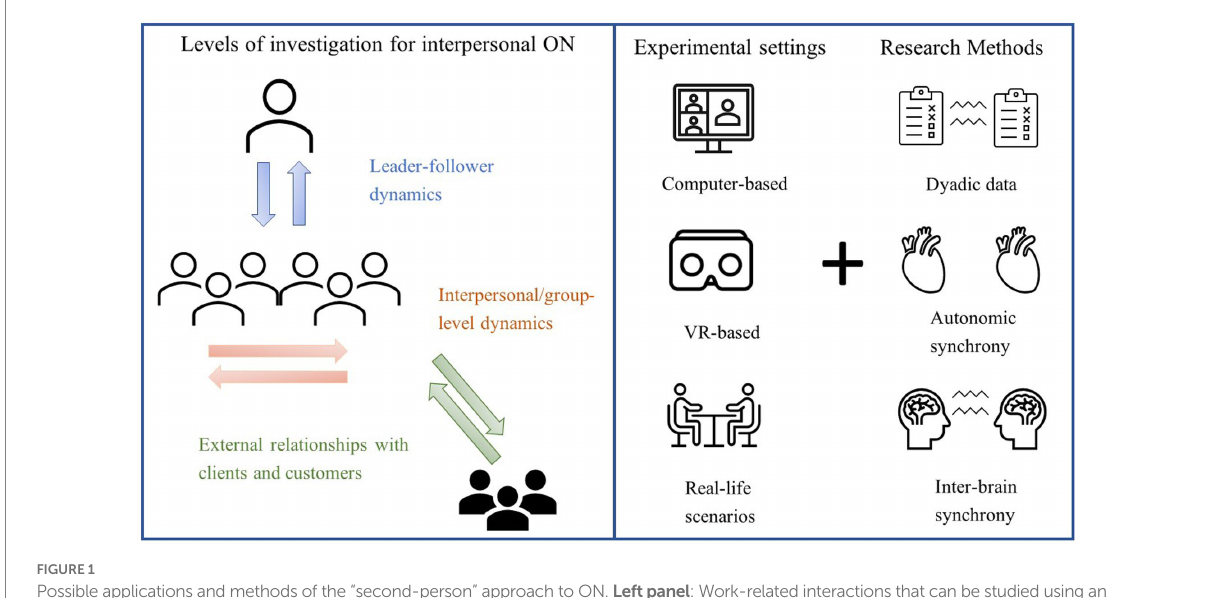
FIGURE 1 Possible applications and methods of the “second-person” approach to ON. Left panel : Work-related interactions that can be studied using an interactive approach include, but are not limited to, leader-follower(s) exchanges (e.g., measuring the brain activity of a manager addressing a speech to his/her staff rather than to the experimenters), group-level dynamics (e.g., collecting physiological and behavioural data from groups of co-workers engaged in a task) and interactions with external members (e.g., measuring emotional contagion from a salesperson to their customers). Right panel : Interactivity in ON research can be ensured even by using computer-based tasks, provided that the presence of other participants is made salient. Using virtual reality (VR), researchers can recreate realistic scenarios in which participants can interact with human-like avatars, which can even be animated by the movements of a real person. Real-life scenarios (where participants interact with flesh-and-bone others), provide the highest level of